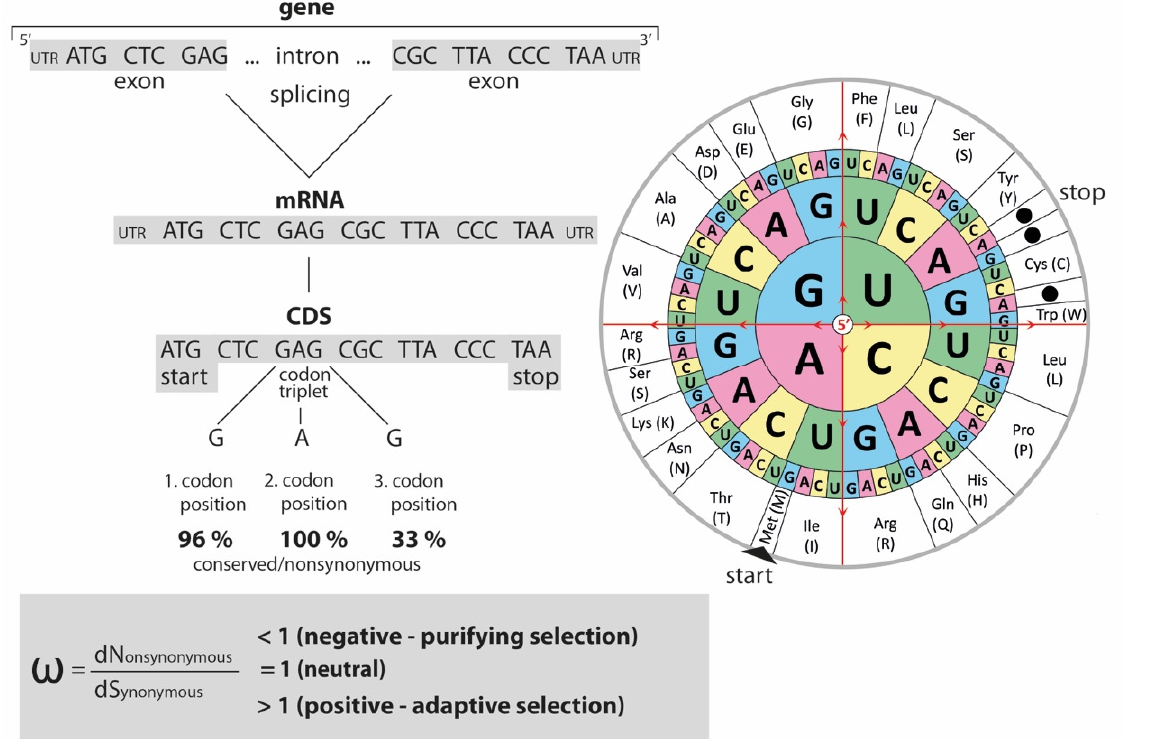
Figure 1. Gene structure, conservation, and DNA to amino acid translation. Exons (including terminal UTR) and introns are assembled to form genes (regulatory regions are not shown). After the splicing of introns, mRNA triplets forming the CDS are translated into amino acids according to the amino acid code (right; codon wheel from 123RF.com, 24366216, accessed on 10 May 2022). The impact of a point mutation in a codon depends on its position. Totals of 96%, 100%, and 33% of changes at the first, second, and third codon positions, respectively, result in amino acid changes (nonsynonymous changes dN) as opposed to synonymous changes (dS), which do not affect the amino acid sequences/protein translation. A dN/dS ratio (omega ⍵ ) of 1 indicates the neutral evolution of the protein. Values lower than 1 suggest negative purifying selection and above 1 positive or adaptive selection.